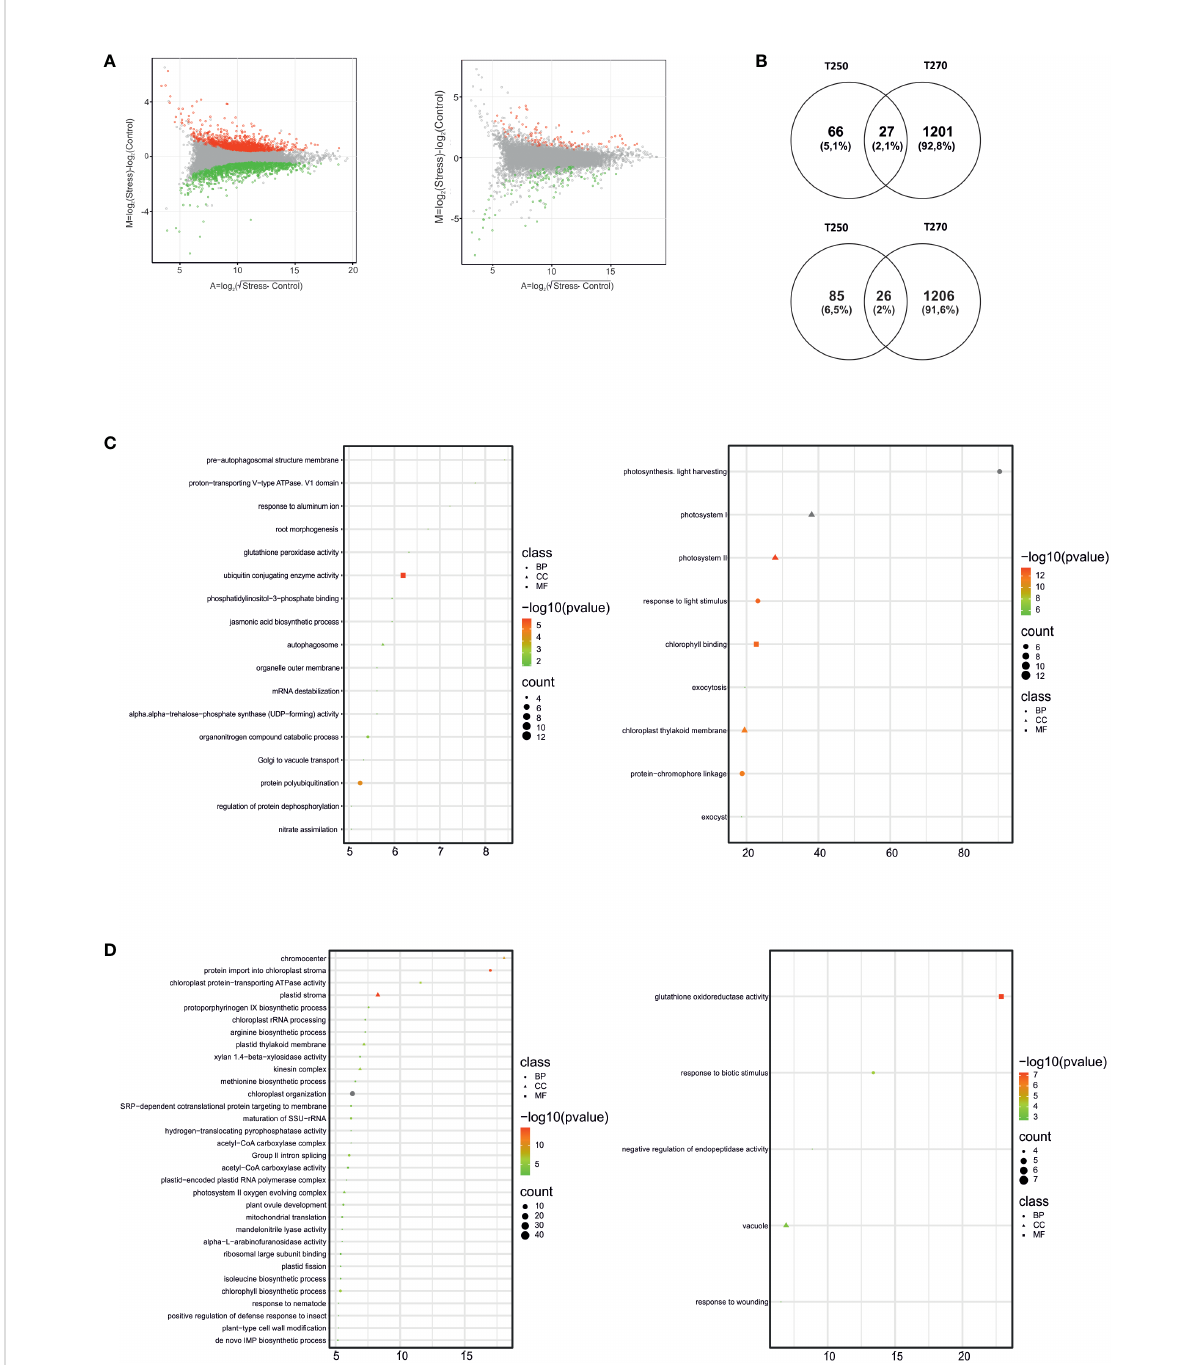
FIGURE 4 Differentially expressed genes (DEGs) and enriched Gene Ontology terms in leaves of T250 and T270 subjected to combined stress. (A) MA plots depicting the distribution of DEGs (green dots, down-regulated, red dots, up-regulated) in T270 (left) and T250 (right) leaves. X-axis: log 2 mean expression across treatments; Y-axis: log 2 expression fold change in combined stress vs. control treatments. (B) Venn diagrams depicting number and overlap of up-regulated (upper panel) and down-regulated (lower panel) DEGs in leaves of combined stress-treated T250 and T270. The diagrams were drawn using the online tool Venny (Oliveros, 2007-2015); (C, D) Plots showing enriched GO terms in leaf DEGs up (C) or down-regulated (D) in T270 (left) or T250 (right). Symbols indicate GO categories: MF, Molecular Function; CC, cellular compartment, BP, biological process. Symbol sizes are proportional to the gene count, whereas colors represent FDR values< 0.05. X-axis: enrichment score. Categories with ES> 5 and gene count > 4 are